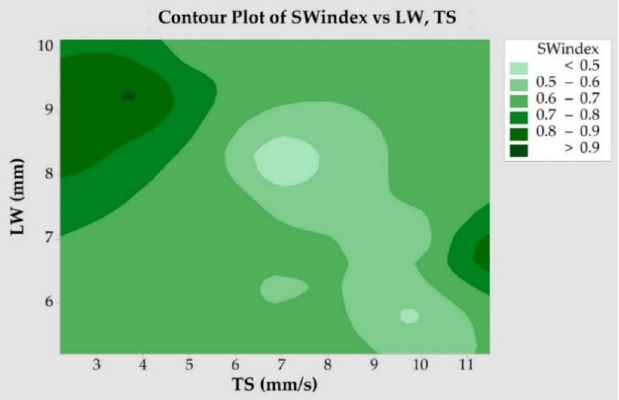
Figure 21. Surface plot of SW index for the working envelope.